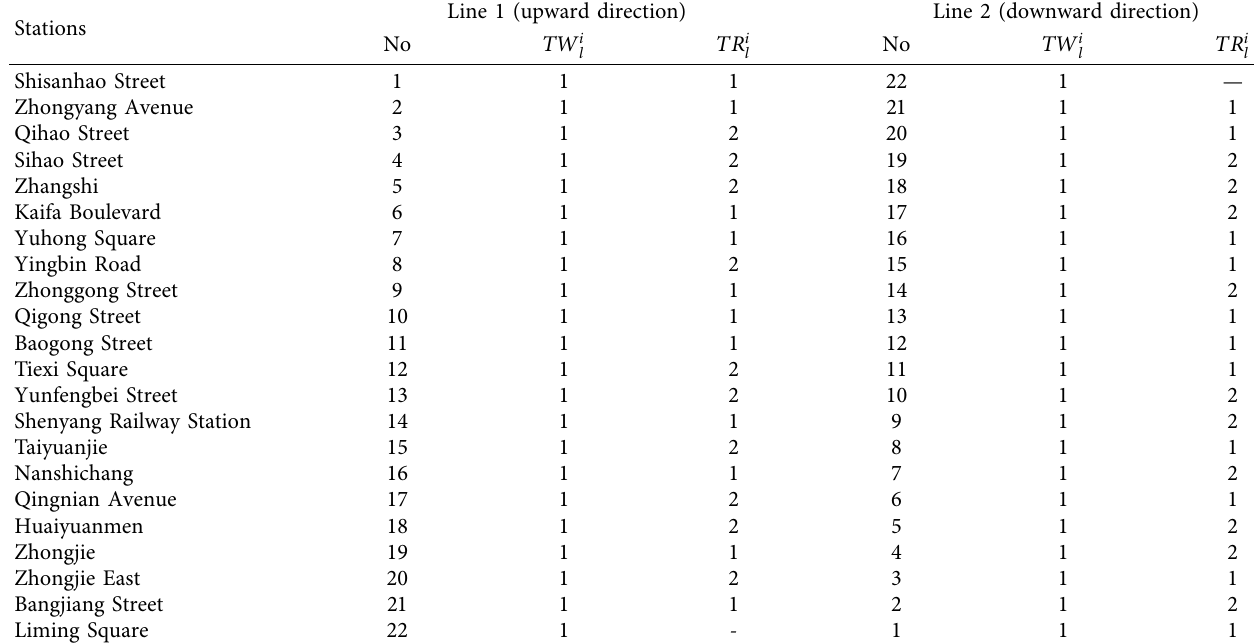
Table 12: Dwell time and running time of the trains on line 1 in Shenyang Metro.